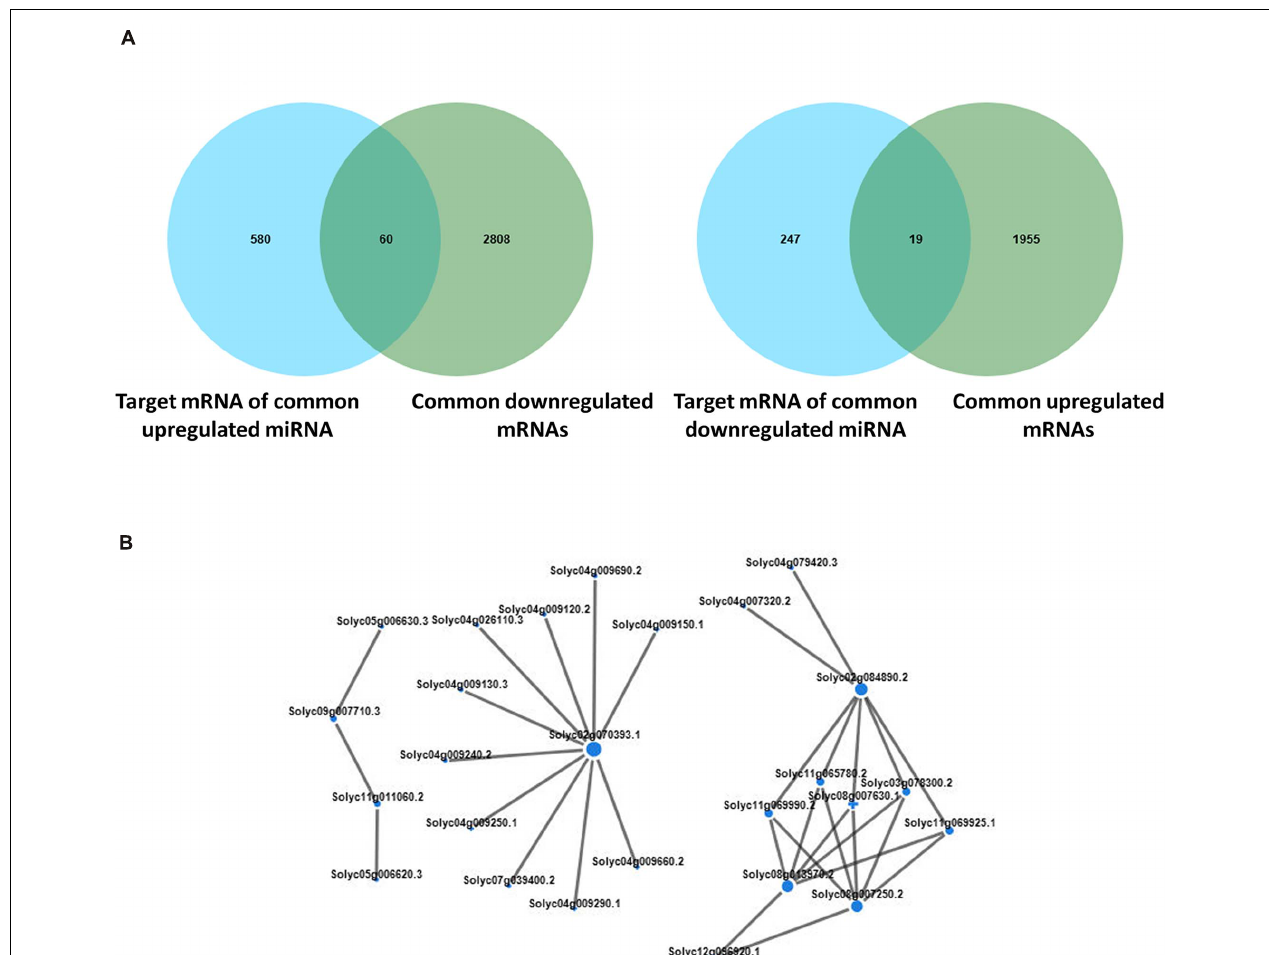
FIGURE 9 | Conjoint analysis of differentially expressed genes and differentially expressed miRNAs. (A) Venn analysis of the predicted miRNA target mRNAs and differentially expressed mRNAs with the same expression trend in tomato plants under different treatment. The left panel shows the common highly expressed mRNAs, and the right panel shows the common lowly expressed mRNAs. (B) Interaction networks of the common up- and down-regulated miRNAs and target mRNAs. H, healthy tomato plants. HQ, tomato plants was fed on by healthy B. tabaci for 24 h. V, tomato plants was inoculated with ToCV. VQ, tomato plants with ToCV that were fed on by healthy B. tabaci for 24